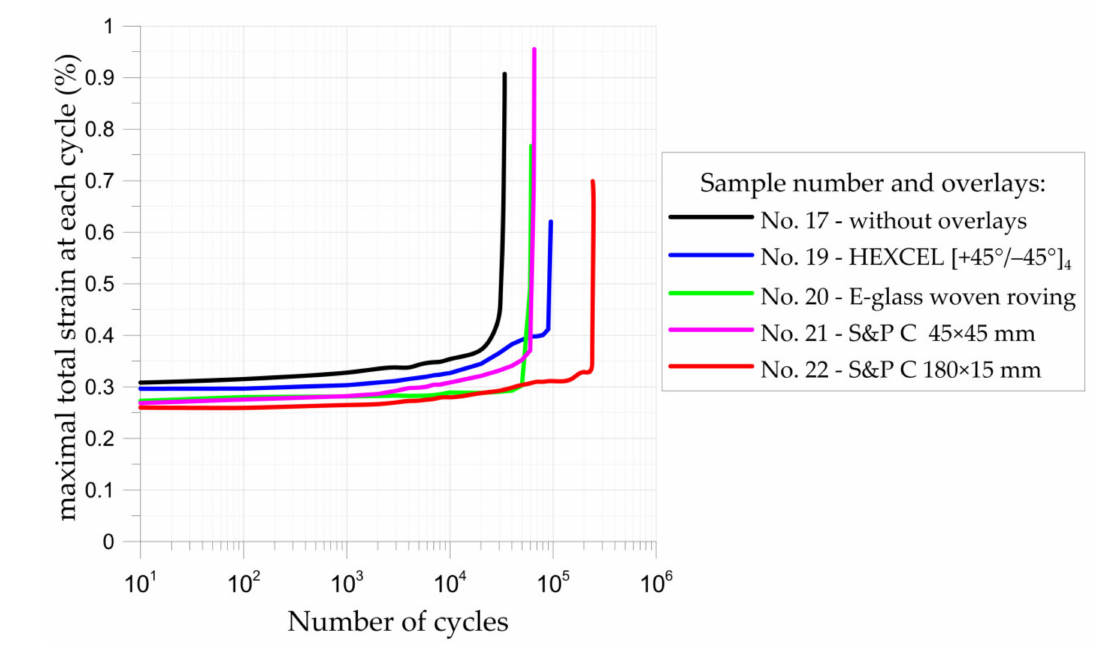
Figure 22. Maximal total strain vs. number of cycles curves for notched samples. Table 4. Results of experimental fatigue tests of notched metal samples; maximal tensile